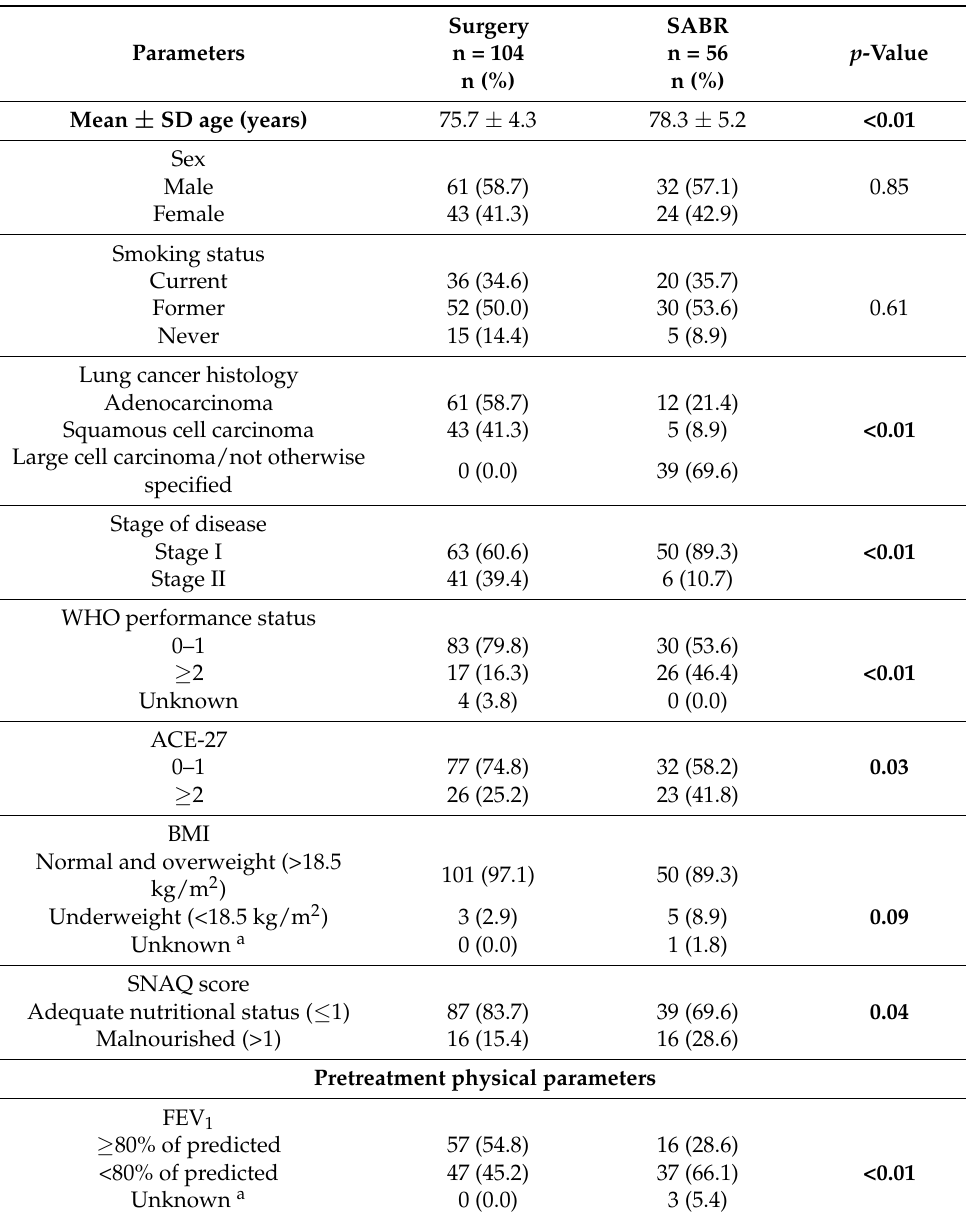
Table 1. Overview of patient and tumor characteristics (including pretreatment physical and geriatric parameters at baseline) of patients with stage I–II NSCLC aged ≥ 70 years according to treatment